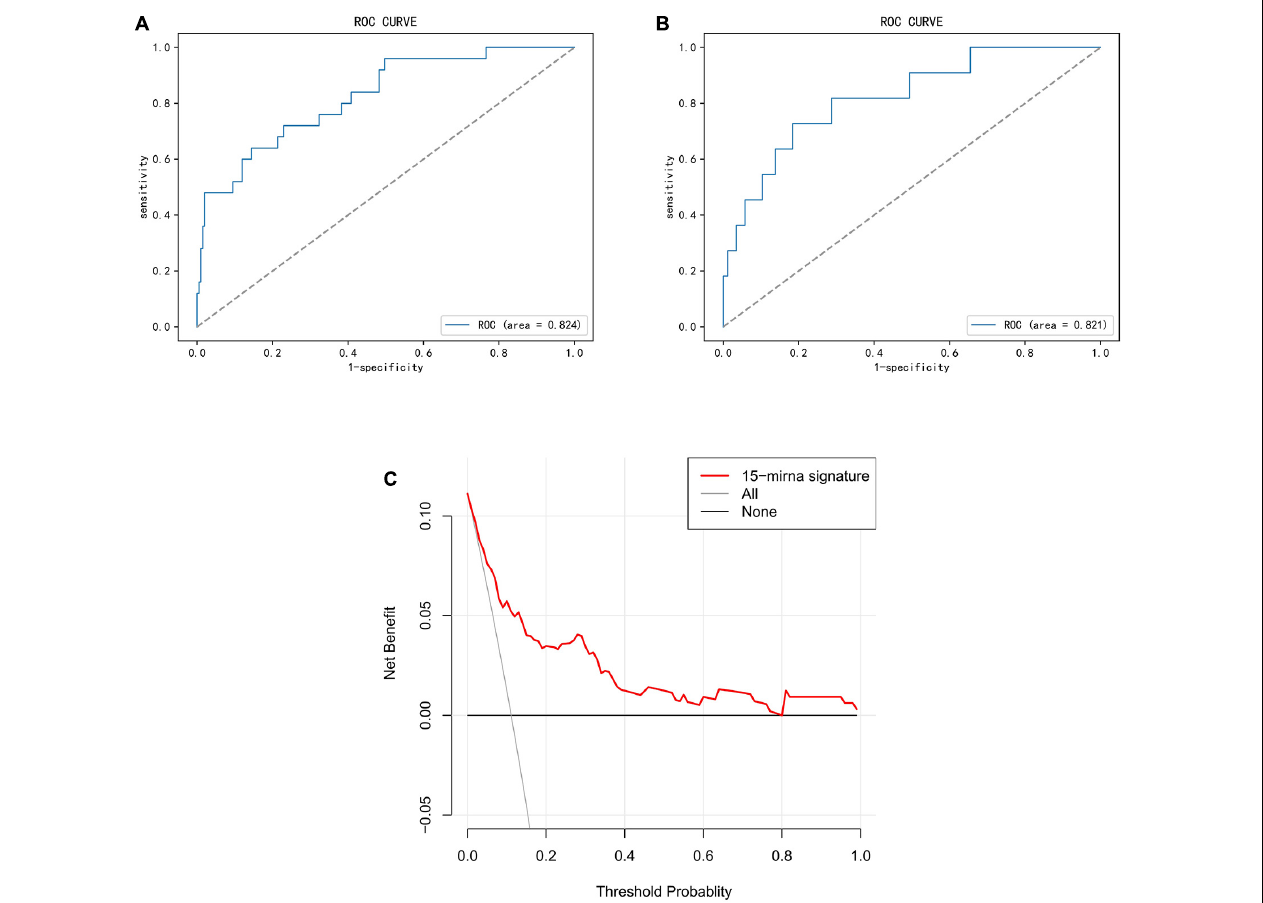
FIGURE 3 | Validation of miRNA signature in predicting lymph node metastasis (LNM) in endometrial endometrioid carcinoma (EEC). This figure describes the performance of miRNA signature in predicting LNM in EEC. (A,B) Receiver operating characteristic curve (ROC) of the miRNA signature in the training cohort and the validation cohort. (C) Decision curve analysis (DCA) for the miRNA signature. The Y-axis represented net benefit. The X-axis represented threshold probability. The threshold probability was where the expected benefit of treatment is equal to the expected benefit of avoiding treatment. The red line represented the miRNA signature. The blue line represented the hypothesis that all patients had LNM. The black line represented the hypothesis that no patient had